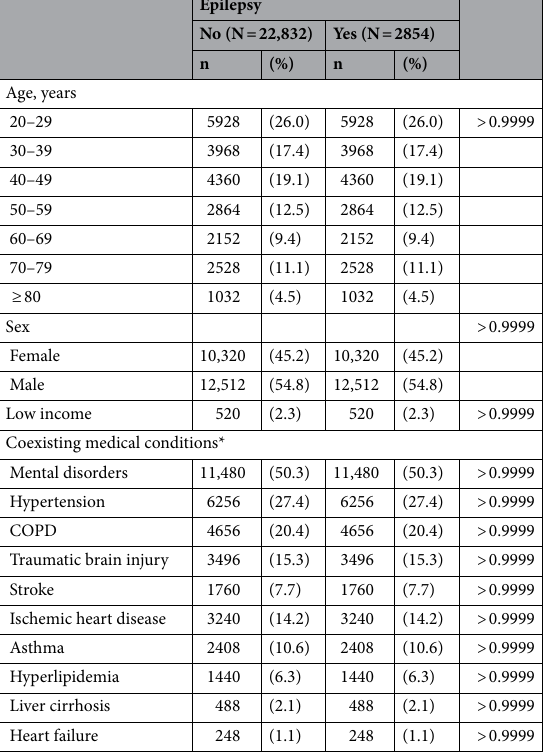
Table 1. Characteristics of study subjects with and without epilepsy. COPD chronic obstructive pulmonary disease. *After propensity-score matching procedure, both groups have no atrial fibrillation or renal